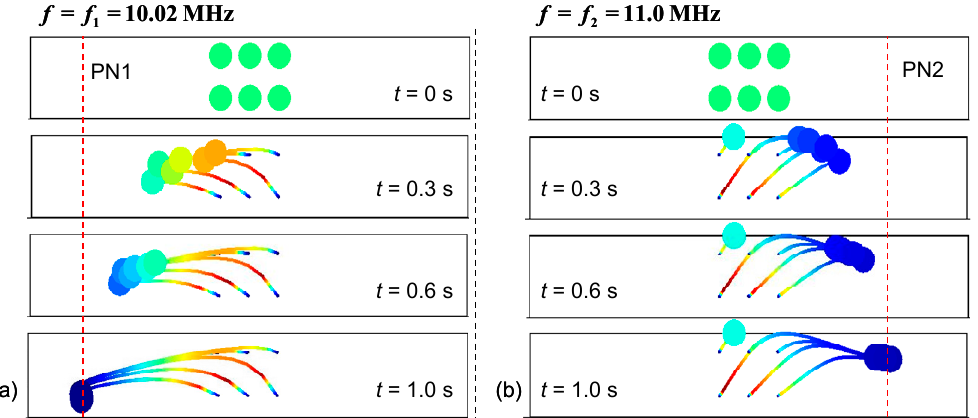
Figure 5. Calculated particle trajectories in the parallel IDT design using two different input frequencies: ( a ) f 1 = 10.02 MHz and ( b ) f 2 = 11.0 MHz. An array of six particles (8 µm in diameter) are released from the central region of the channel at time t = 0 s.